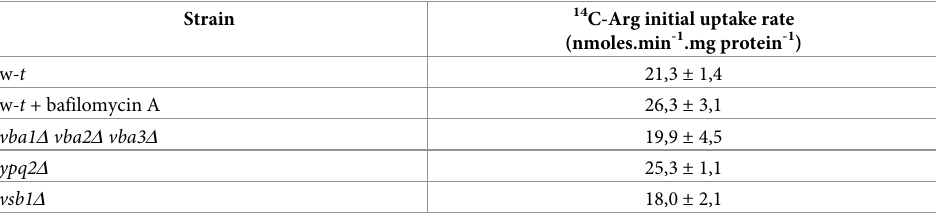
vsb1 Δ Strains were grown on minimal ammonium medium and uptake at 250 μ M was measured after 20, 40, 60 and 80 seconds of incubation. Values were then used to calculate the initial uptake rate via linear regression